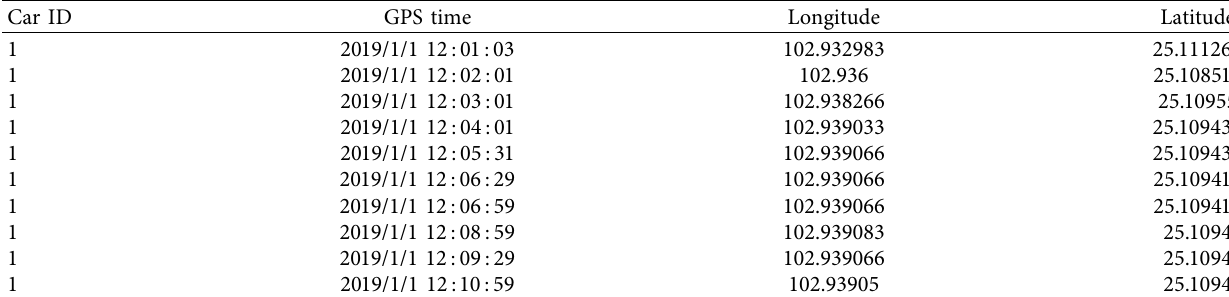
Table 3: GPS trajectory information of the ferry car